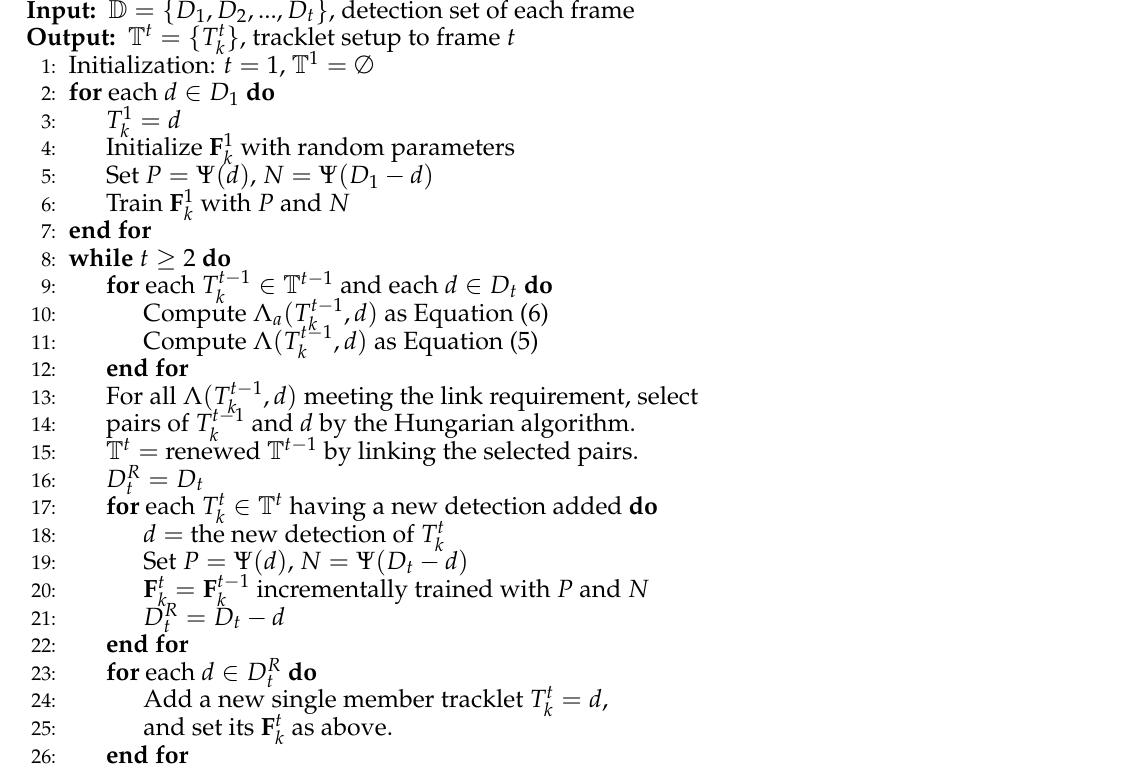
Algorithm 1 Iterative tracklet building with SNAC by incremental